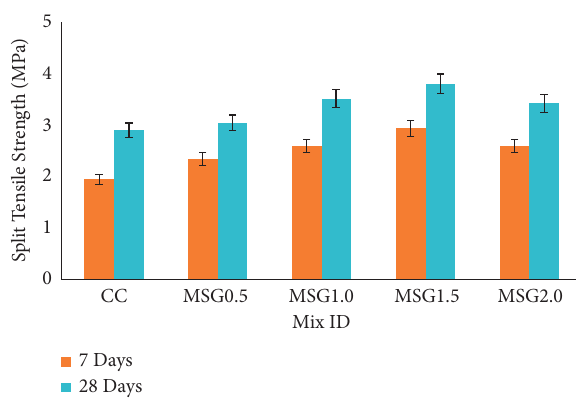
Figure 7: Split tensile strength of various mixes.